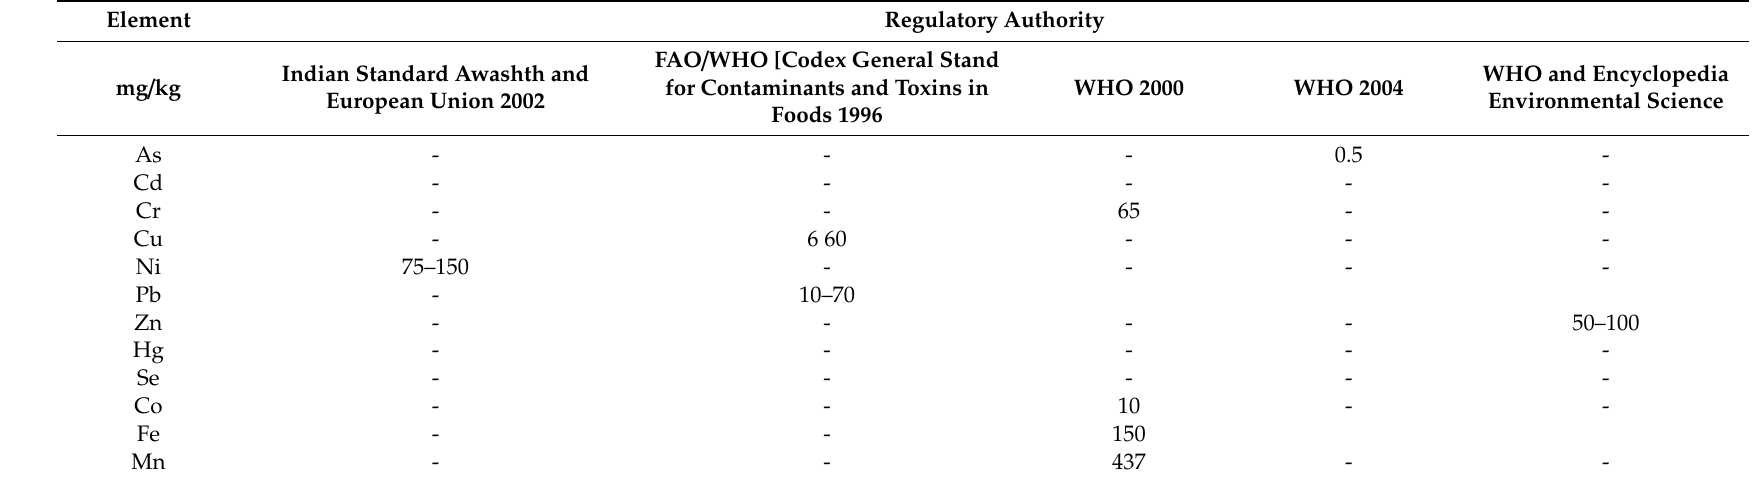
Table 11. General permissible heavy metal limits in agricultural soils according to di ff erent regulatory authorities as adopted from [98]. Element